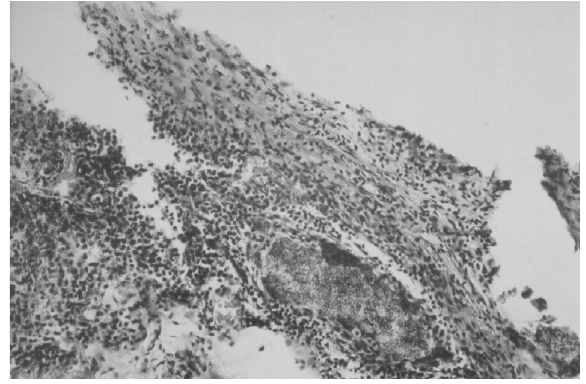
FIGURA 3- Sealapex – 7 dias: resíduos de material e necrose superficial. Proliferação fibro-angioblástica. Atividade macrofágica sobre o material extravasado. HE